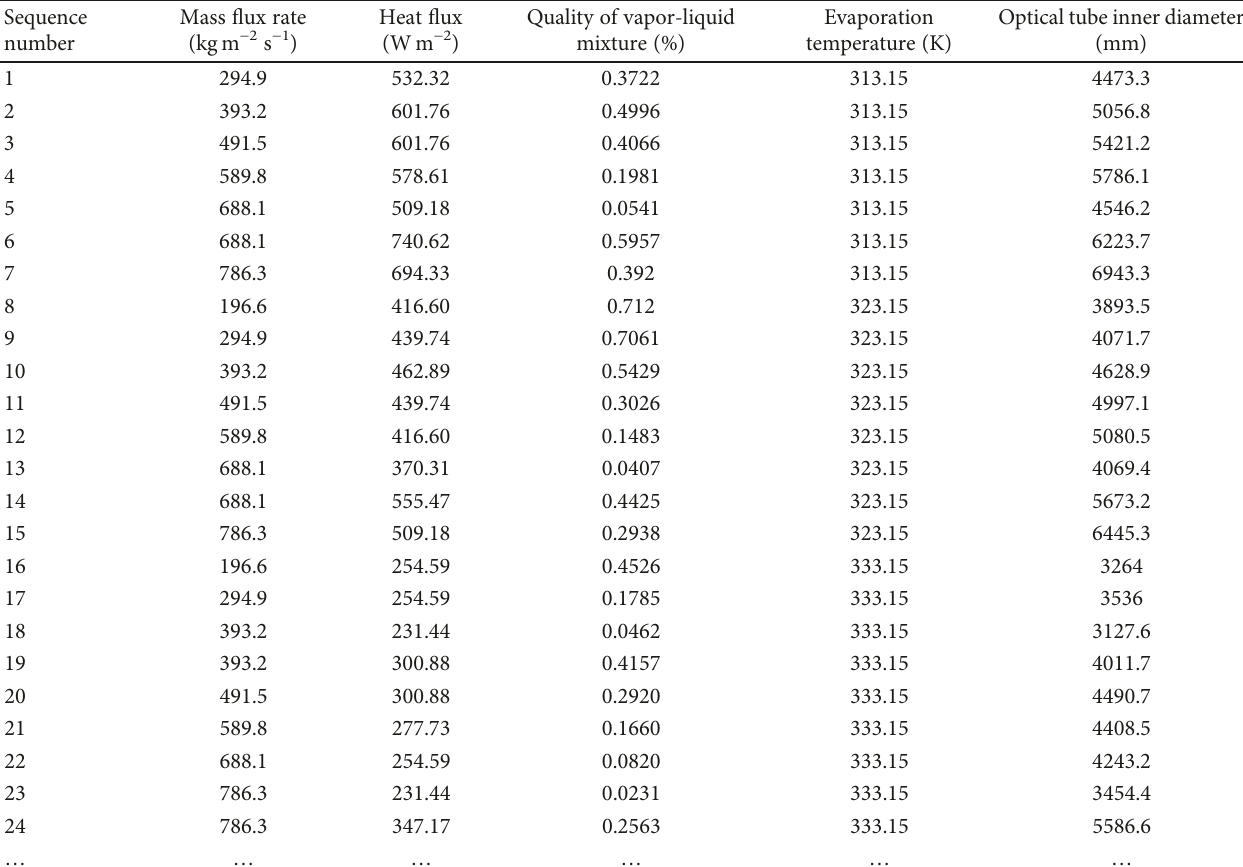
Table 4: Part of the experimental